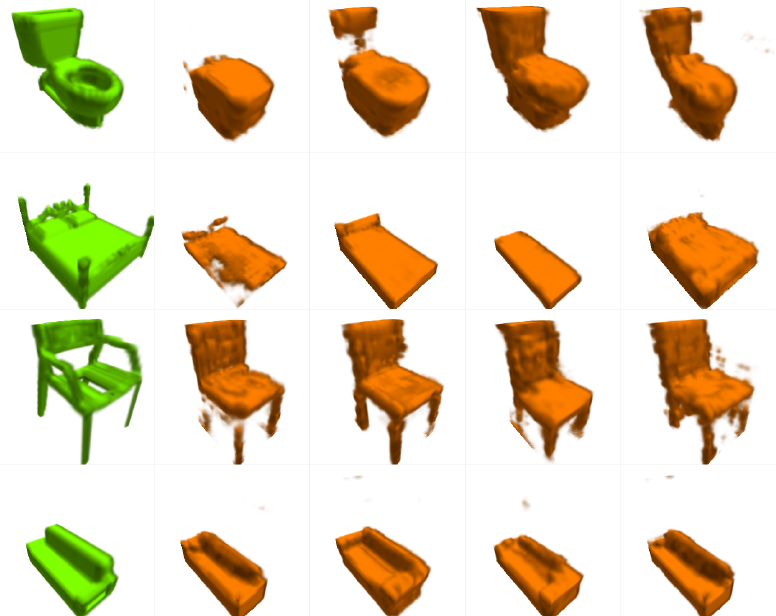
Figure 9. Output of the conditional generator using random input noise. The class condition vector has been constructed so that the rows contain examples from these ModelNet10 classes (top to bottom): toilet, bed, chair, and sofa. The first column contains a random example from the training set. The output of the generator is a 32 3 voxel grid visualized using our voxel rendering pipeline